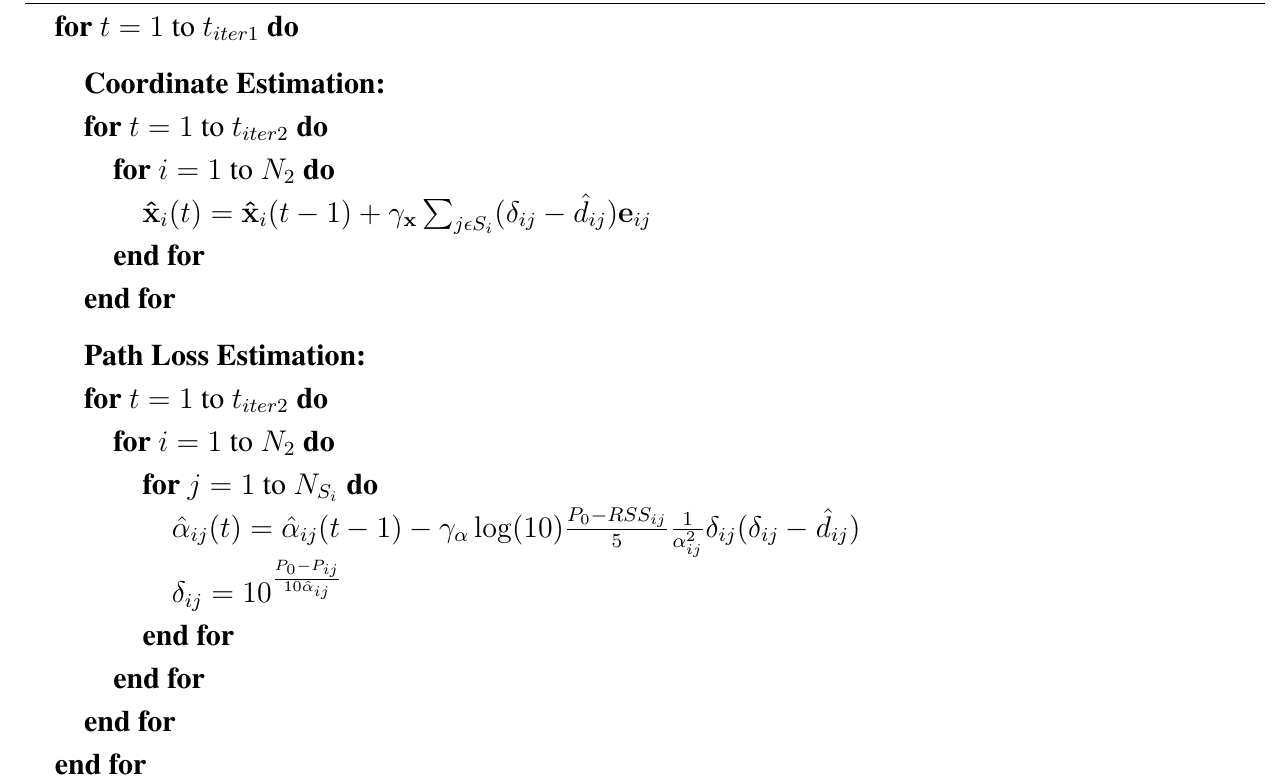
Algorithm 1 LS Localization Algorithm with On-Line Path Loss